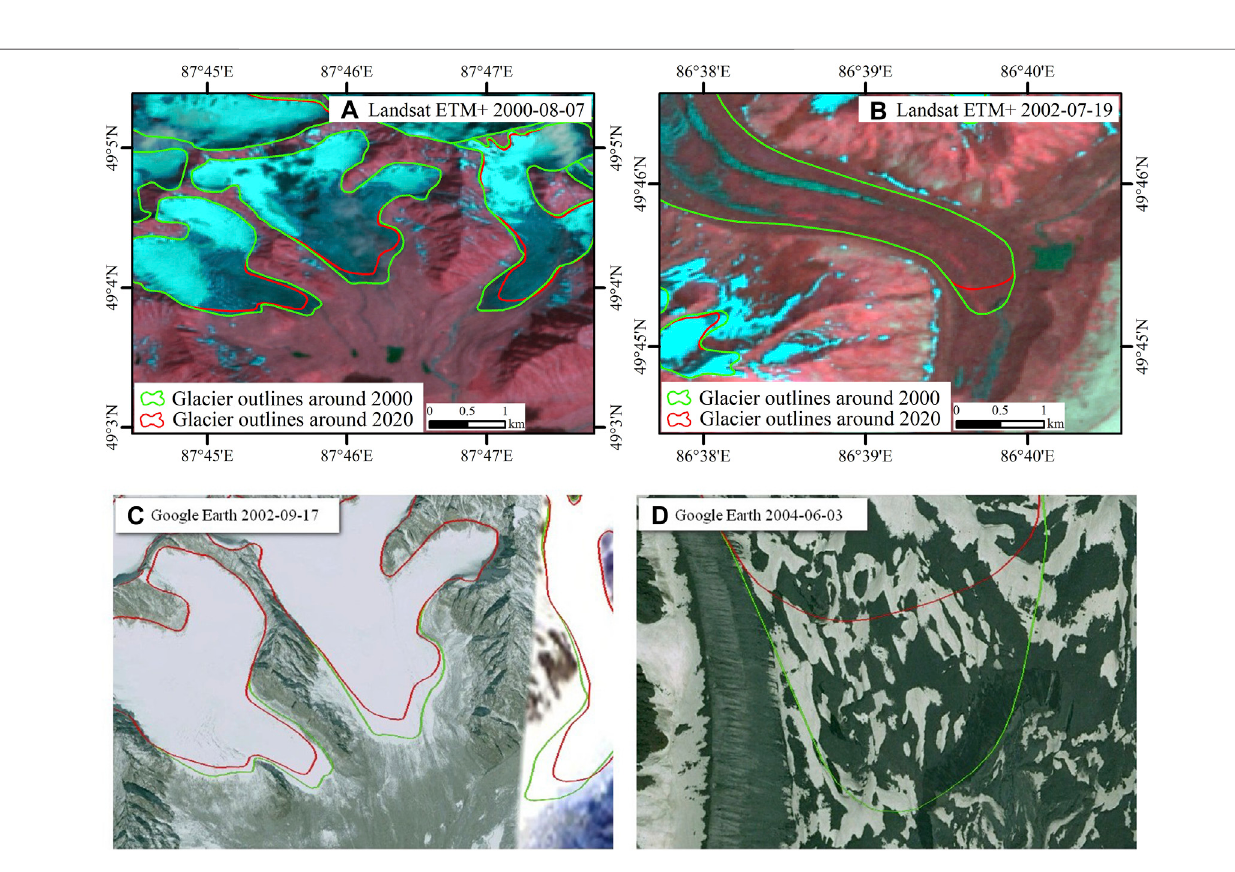
FIGURE 3 | Manual delineation of glacier outlines. (A) Manual delineation of clear ice areas using false-color composite Landsat image. (B) Manual delineation of debris-coveredglacieroutlinesusingfalse-colorcompositeLandsatimage. (C) GoogleEarthimageofcleariceareas. (D)